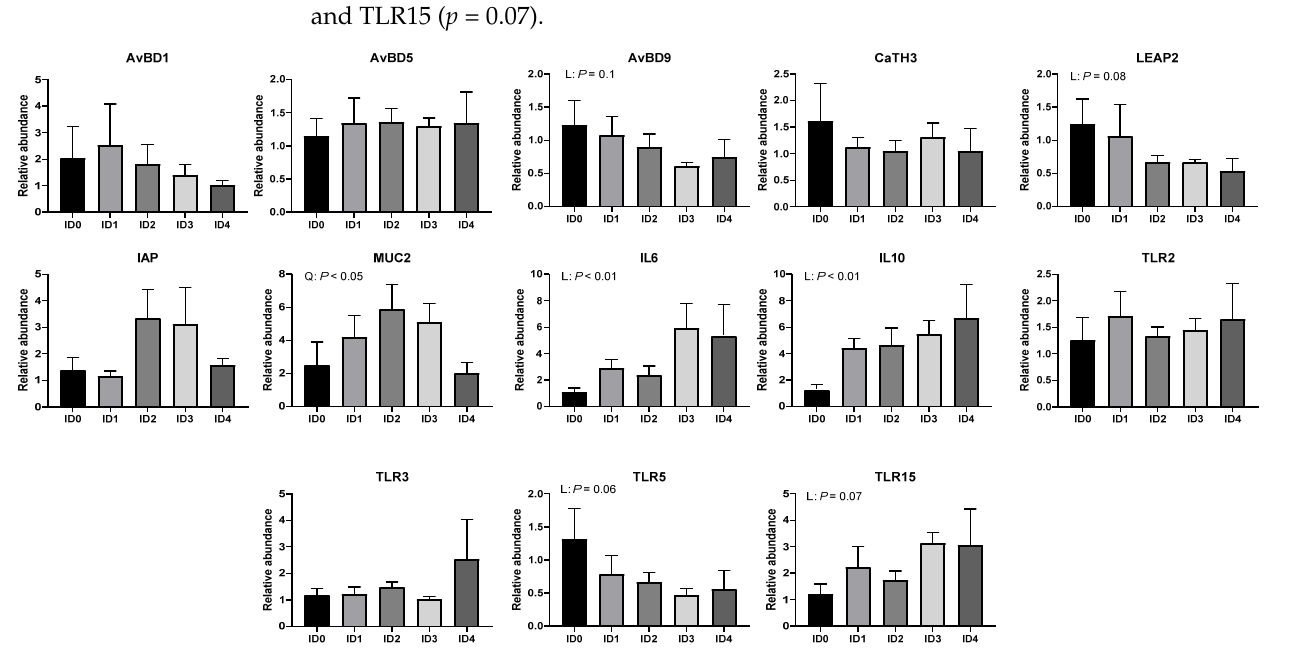
Figure 10. Effects of different infection doses of Eimeria tenella on relative mRNA expression of genes related to antimicrobial peptides, alkaline phosphatase, mucin gene, inflammatory cytokines, and toll-like receptors in the cecal tissue of broilers 6 days post-infection. Relative mRNA expression was determined in the ID0 (infection dose 0; Sham-challenged with phosphate-buffered saline); ID1 (infection dose 1; challenged with 6250 sporulated oocysts of Eimeria tenella ); ID2 (infection dose 2; challenged with 12,500 sporulated oocysts of E. tenella ); ID3 (infection dose 3; challenged with 25,000 sporulated oocysts of E. tenella ); ID4 (infection dose 4; challenged with 50,000 sporulated oocysts of E. tenella ) groups. Data were analyzed by using One-way ANOVA followed by the Tukey’s multiple comparison test. Orthogonal polynomial contrast analysis was used to assess linear (L) and quadratic (Q) effects of the infection doses, and p < 0.1 were presented.